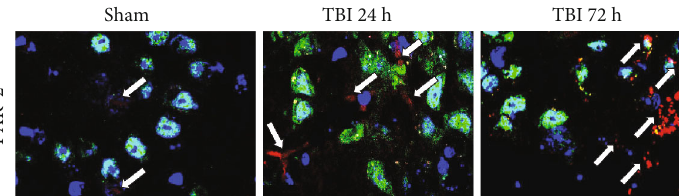
Figure 4: Acute TBI increases PAR-2 expression in the brain. PAR-2 expression was analyzed in the frozen sections (20 μ m) from the brains of 24 h and 72 h weight drop model of TBI and sham control mouse brains without TBI ( n = 3 mice/group). We analyzed the expression of PAR-2 (red color) for in fl ammation and NeuN (green color) for neurons in these brain sections by triple immuno fl uorescence staining. Cellular nuclei were stained with DAPI (blue color). Representative photomicrographs show increased PAR-2 expression (red color, white arrows) in 24 h and 72h acute TBI brains as compared with sham control mouse brains without TBI. Photomicrograph original magni fi cations =630x.